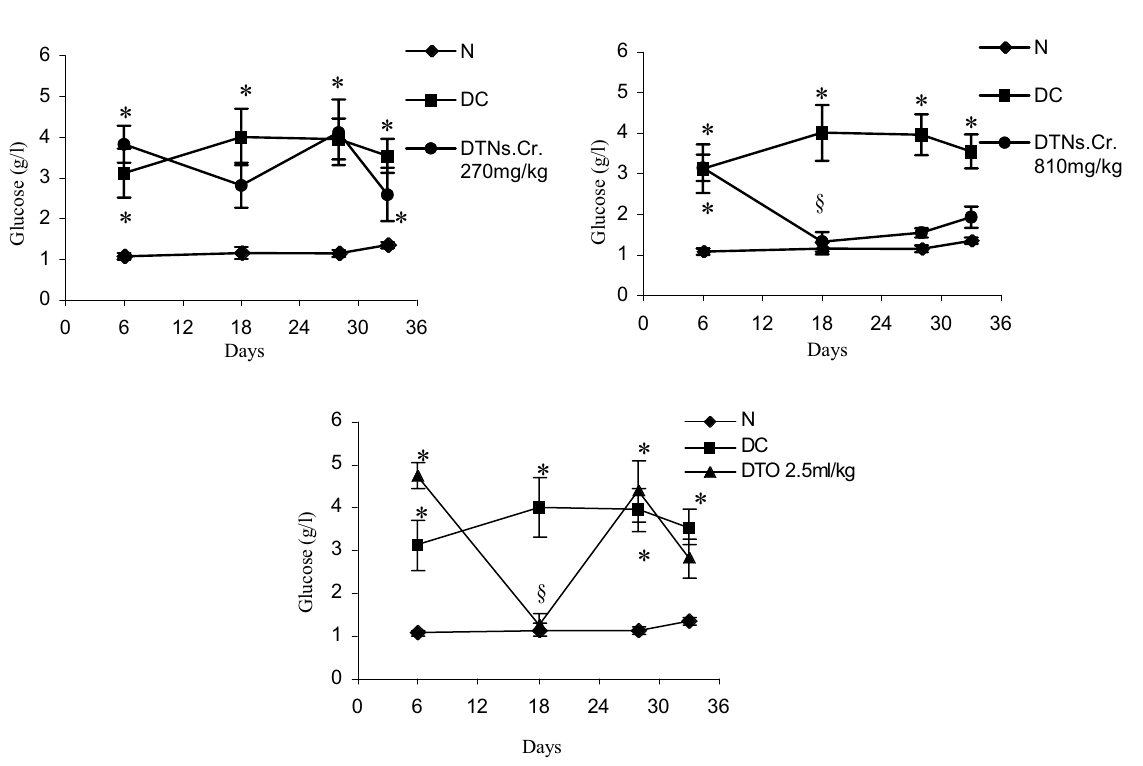
Figure 2. Variation of plasmatic glucose during experiment in all rats. N, normal rats group (n=5); DC, diabetic control rats group (n=5); DTNs.Cr, N. sativa crude extract treated diabetic rats group (n=5); DTO, oil treated dia- betic group (n=5). Values are expressed as mean ± SEM.*Significantly different from N-rats group by ANOVA test, p < 0.05. § Significantly different from DC-rats group by ANOVA test, p <